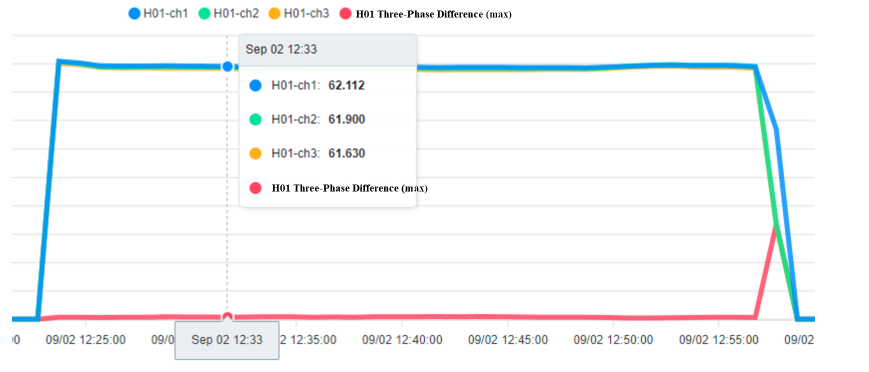
Figure 15. Balanced Three-Phase Load.